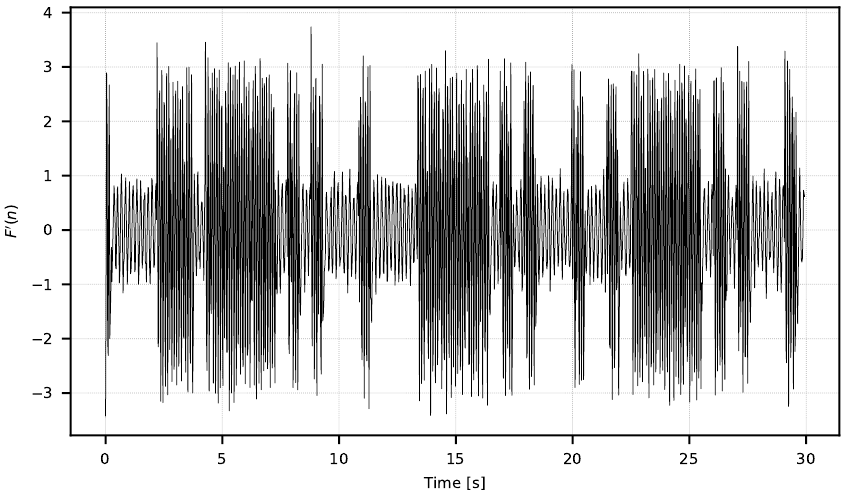
Figure 7. Signal F (cid:48) after high-pass